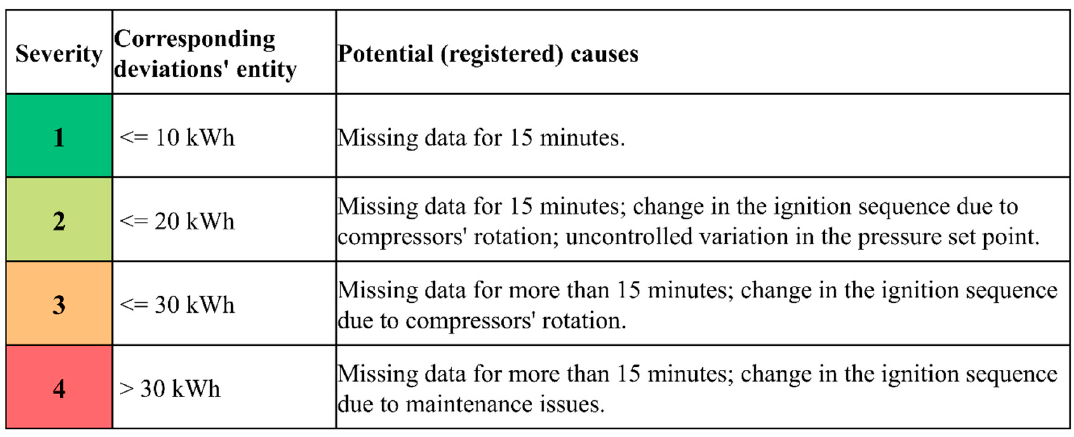
Figure 10. CuSum chart and control charts for the energy performance deviations for the two-month control period (data aggregated every four hours).